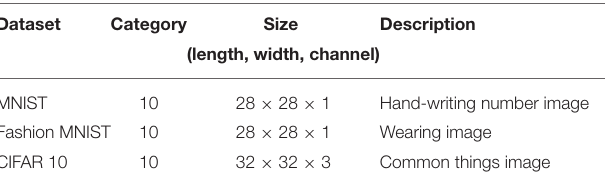
TABLE 1 | Details of the dataset.